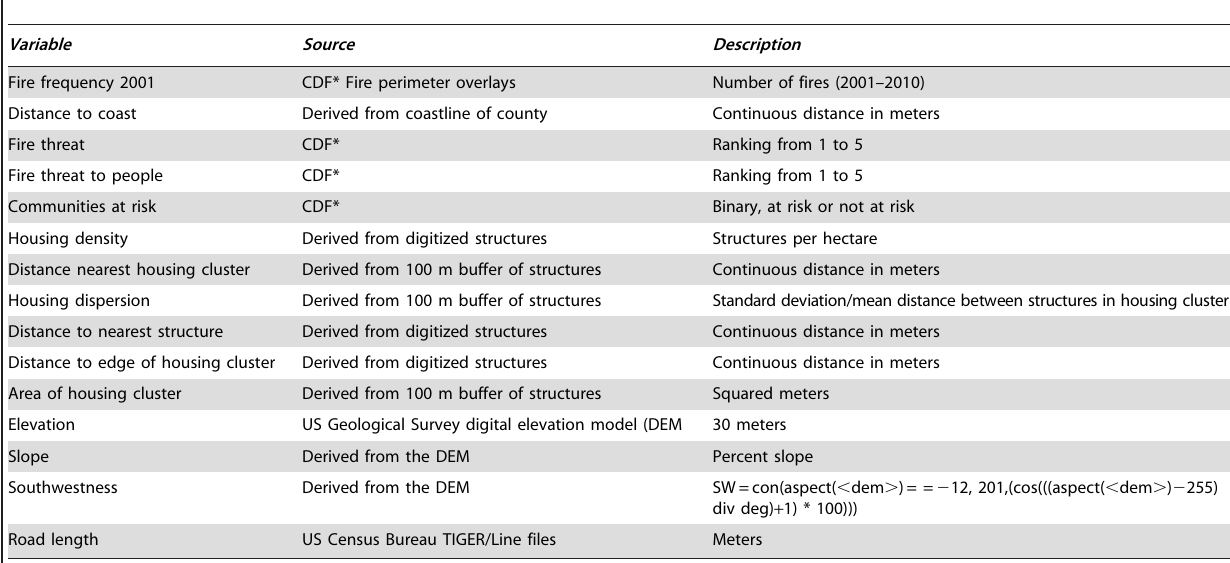
Table 1. Variables analyzed for explaining structure loss in the Santa Monica Mountains and San Diego